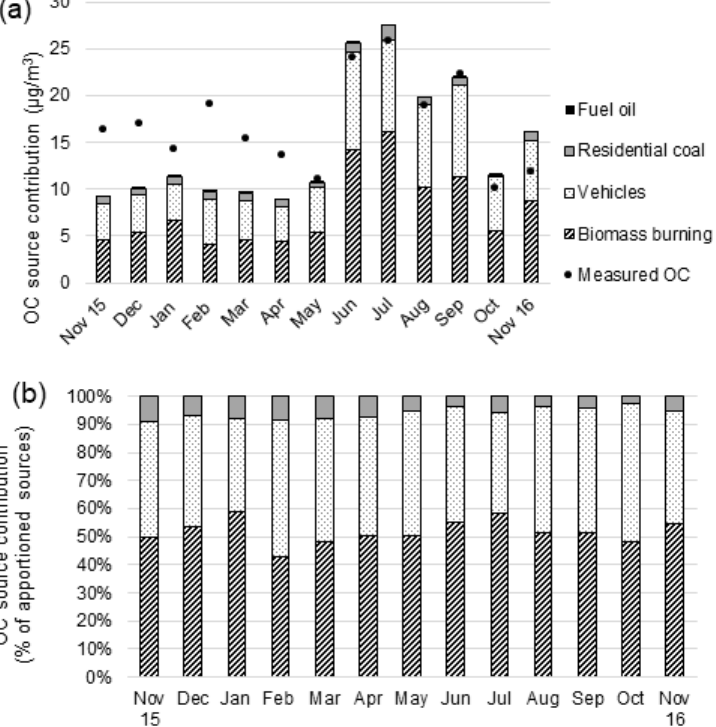
Figure 2. Chemical mass balance (CMB) organic carbon (OC) source contribution estimates in units of ( a ) μ g.m − 3 and ( b ) percentage of apportioned OC in Addis Ababa, November 2015 to November 2016.